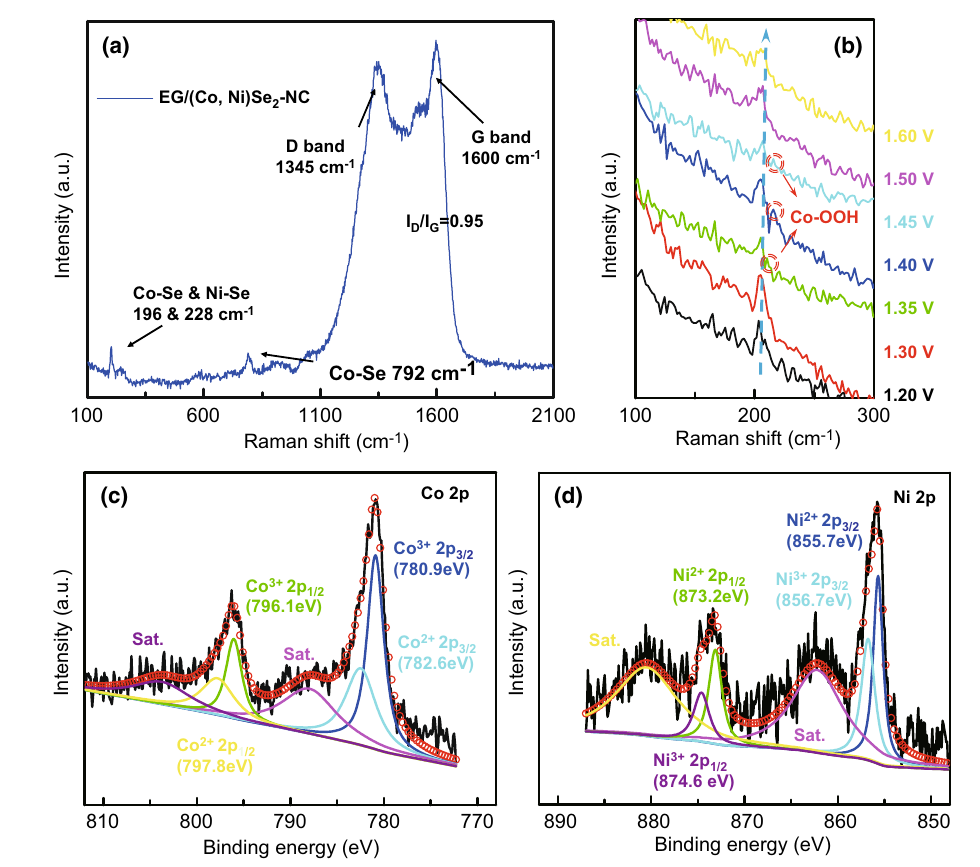
Fig. 5 a Raman spectrum of EG/(Co, Ni)Se 2 –NC. b In situ electrochemical Raman spectra of EG/(Co, Ni)Se 2 –NC, potential ranges from 1.2 to 1.6 V. c High-resolution XPS spectrum of Co 2 p in EG/(Co, Ni)Se 2 –NC after OER. d High-resolution XPS spectrum of Ni 2 p in EG/(Co, Ni) Se 2 –NC after OER